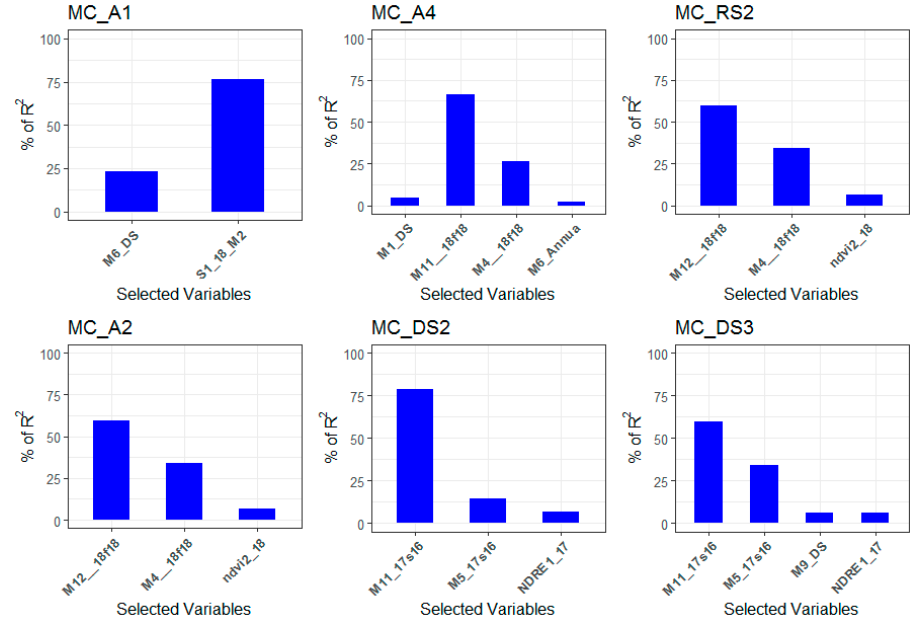
Figure 3. Variable importance for individual predictor variables extracted using MC based methods.